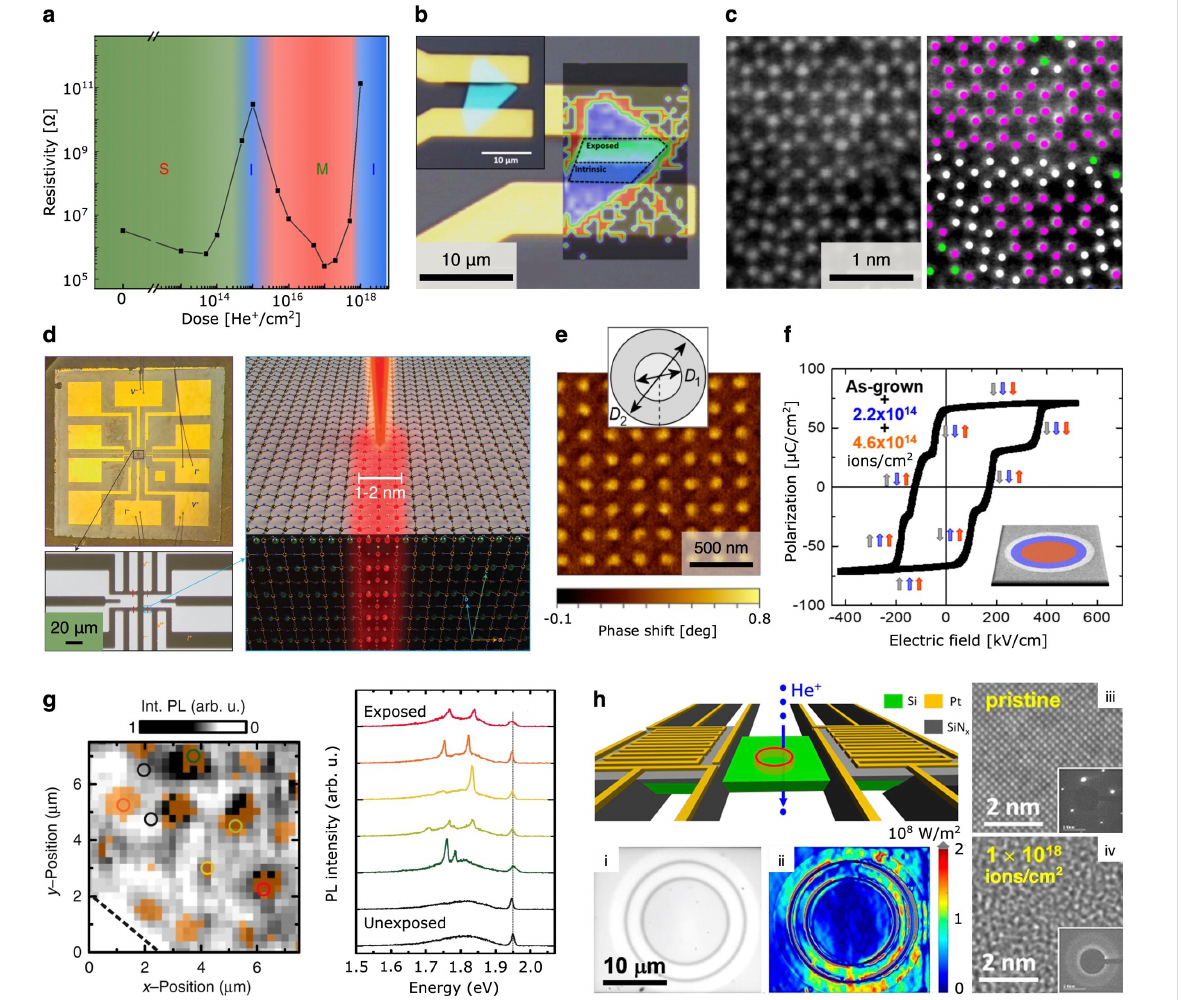
Figure 2: Defect engineering using the HIM. (a) Plot of resistivity versus dose for helium ion-irradiated MoS 2 (few-layer) showing multiple phase tran- sitions: semiconducting (S), insulating (I), metallic (M). Reprinted with permission from [25]. Copyright 2015 American Chemical Society. (b) Elec- tronic homojunction in few-layer WSe 2 created by site-selective helium ion irradiation: colorized Raman map on the right with optical micrograph of the device shown top left. Adapted from [29]. Copyright 2016 Stanford et al., licensed under a Creative Commons Attribution 4.0 International License, http://creativecommons.org/licenses/by/4.0/. (c) STEM-based analysis of atomic defects in single-layer MoSe 2 created by helium ion irradiation. Adapted from [30]. Copyright 2016 Iberi et al., licensed under a Creative Commons Attribution 4.0 International License, http://creativecommons.org/ licenses/by/4.0/. (d) Fabrication of Josephson junctions in a thin-film high-temperature superconductor by helium line irradiation: YBCO-based device with gold contacts (left) and schematic showing the irradiation approach (right). Adapted by permission from Springer Nature, [31], Nature Nanotech- nology, Nano Josephson superconducting tunnel junctions in YBa 2 Cu 3 O 7 −δ directly patterned with a focused helium ion beam, Cybart et al. Copy- right 2015 Nature Publishing Group. (e) Magnetic force microscopy of a nanoscale array of discs with reduced magnetic anisotropy patterned into a Co/Pt multilayer: concentric helium ion irradiation scheme for each disc shown inset. Adapted from [32]. Copyright 2019 Sapozhnikov et al., licensed under a Creative Commons Attribution 4.0 International License, https://creativecommons.org/licenses/by/4.0/. (f) Multilevel ferroelectric switching of nanostructures fabricated by helium ion irradiation of a PbZr 0.2 Ti 0.8 O 3 thin film using concentric patterns with variable dose. Adapted with permission from [33]. Copyright 2018 by the American Physical Society. (g) Site-selective formation of optically active defects in MoS 2 : photoluminescence (PL) map of an array created by localized helium ion irradiation (100 × 100 nm fields, pitch 2 μ m) and corresponding PL spectra for regions marked with the colored circles. Adapted from [34]. Copyright 2019 Klein et al., licensed under a Creative Commons Attribution 4.0 International License, http:// creativecommons.org/licenses/by/4.0/. (h) Demonstration of a microscale thermal cloak using helium ion irradiation to site-selectively tune the ther- mal conductivity of a suspended silicon membrane: schematic of device (top left), (i) optical image showing irradiated regions (darker contrast), (ii) corresponding heat flux map, (iii) TEM analysis of pristine silicon, (iv) TEM analysis of an irradiated region. Adapted with permission from [35]. Copyright 2019 American Chemical Society. The content of (a), (d), (f) and (h) is not subject to CC BY